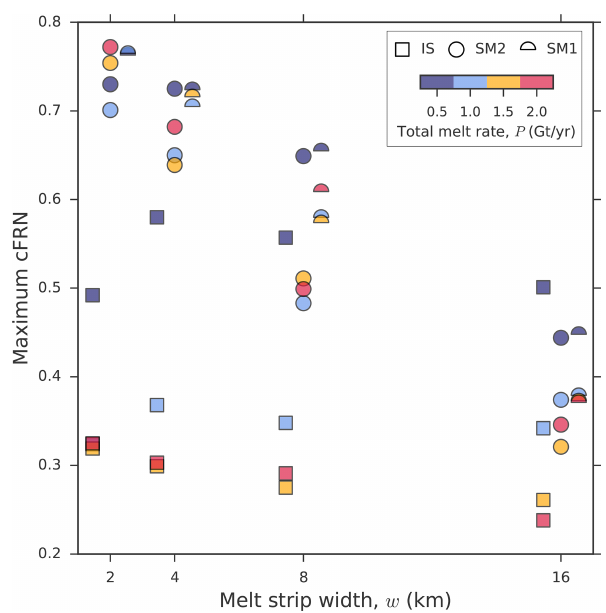
Figure 8. Maximum of the cFRN dependent on the melt-strip width w ( x axis) and perturbation strength P (colorbar). The perturbation types are represented by individual symbols (legend). For better vis- ibility the data points of the three perturbation types are slightly shifted against each other on the x